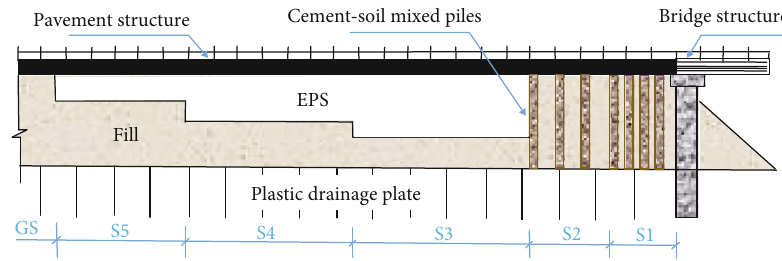
Figure 5: Pro fi le of bridge approach.